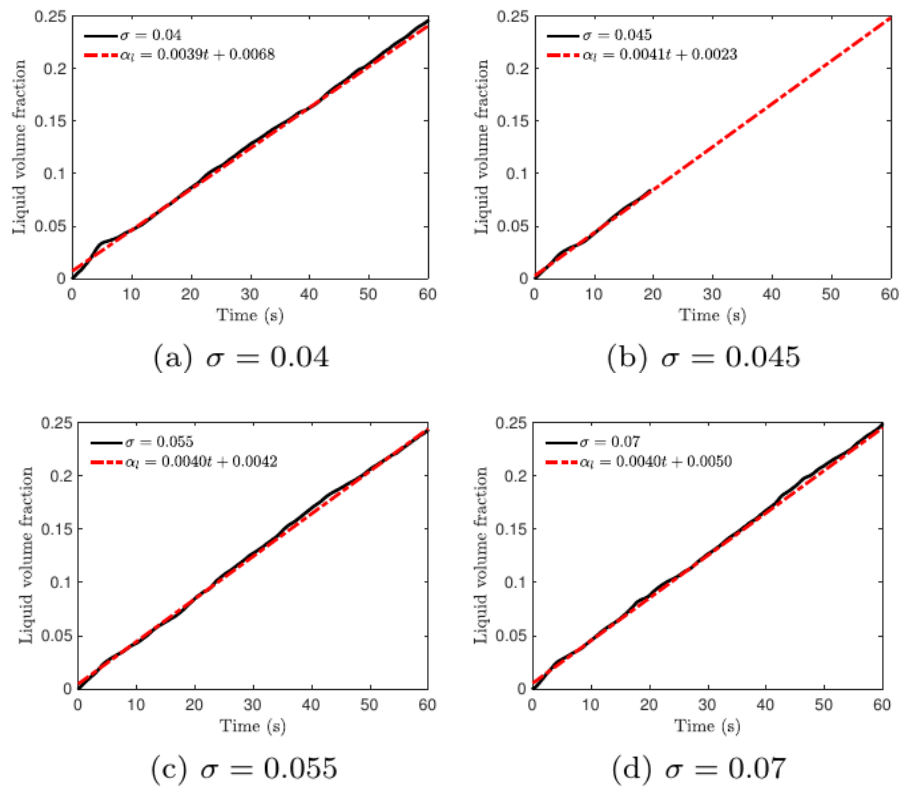
Figure 10. Curves of the liquid volume fraction with the time, together with the linear fitting results, where the surface tensions are